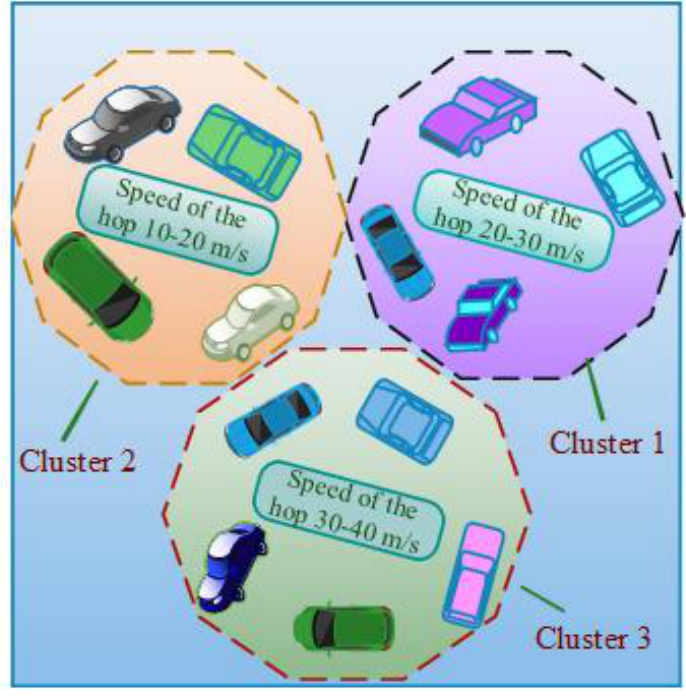
Figure 2. Mobility-dependent clustering